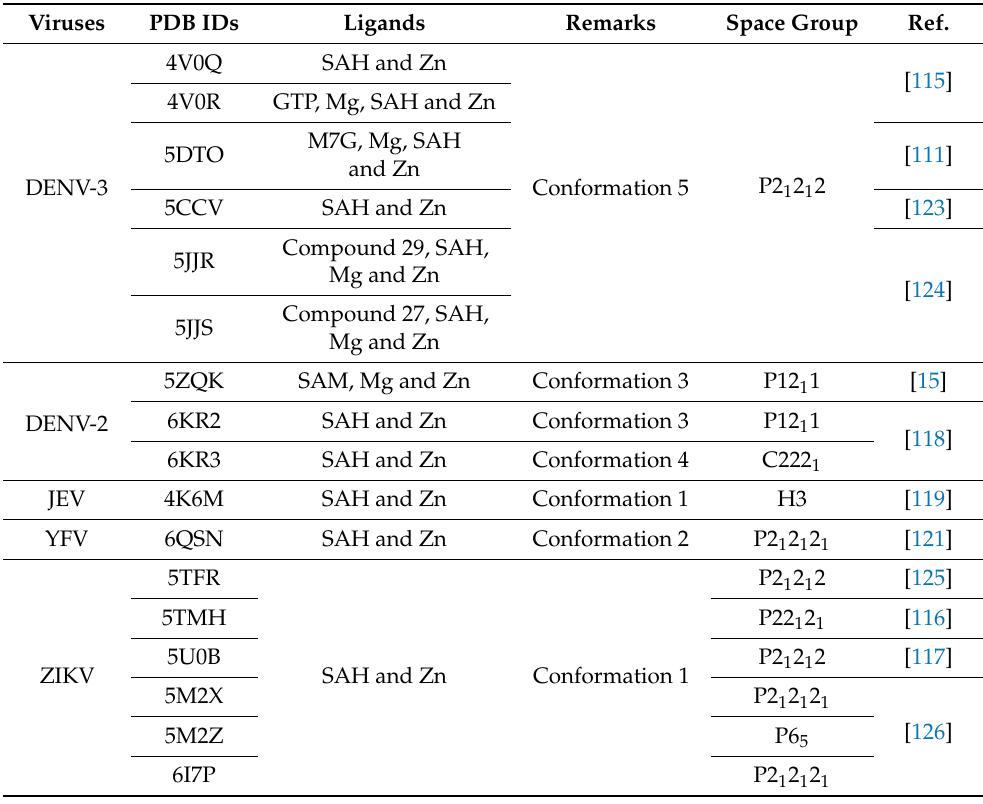
Table 3. A summary of full-length protein structures of the NS5 proteins published on Protein Data Bank. Viruses PDB